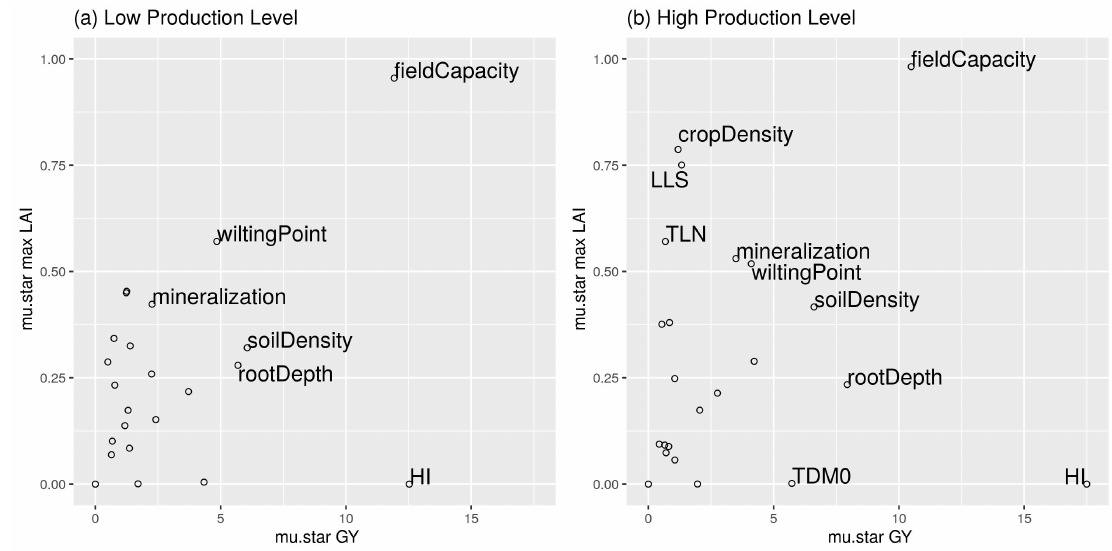
Figure 7. Means of absolute elementary effects (mu.star) computed by the Morris method for two contrasted production situations and for two model outputs: grain yield (GY) and maximal